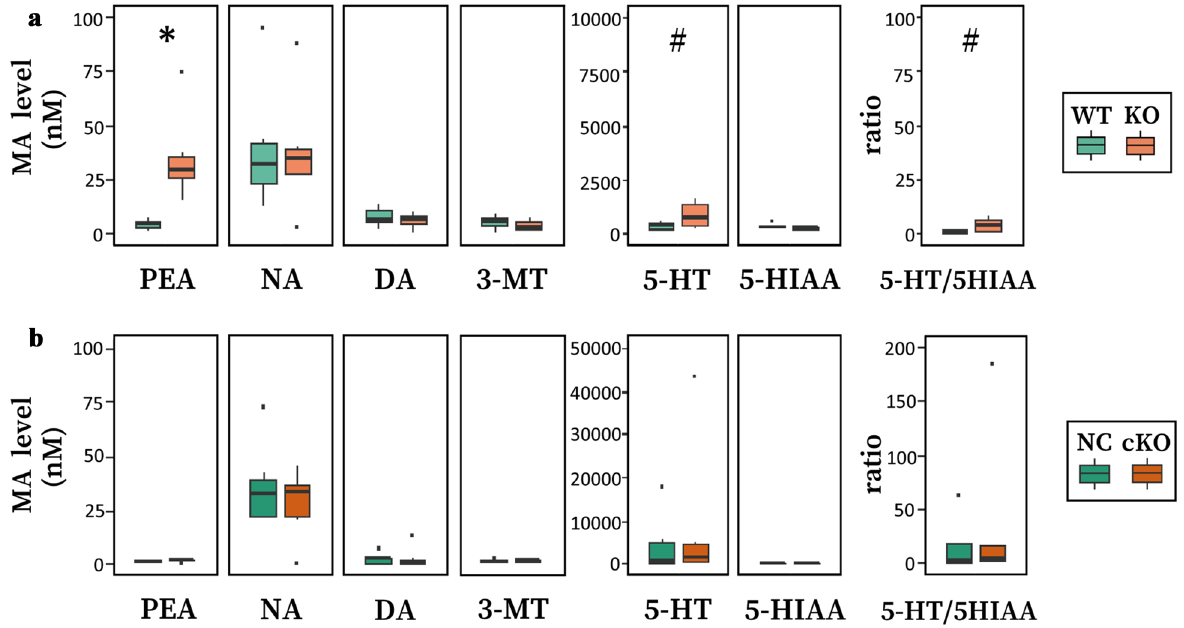
Figure 5. Plasma PEA levels are elevated in global KO mice but not in brain-specific cKO mice. ( a ) Plasma concentrations in wild-type (WT, Maob (+/Y)) and Maob KO (KO, Maob (−/Y)) mice ( n = 6 for each group). Two-way ANOVA showed a significant difference depending on the genotype × substance interaction (genotype: df = 1, F = 3.006, P = 0.0874; substance: df = 6, F = 13.650, P = 3.4 × 10 −10 ; and genotype × substance interaction: df = 6, F = 2.686, P = 0.0210). * P < 0.05, Student’s t- test with Bonferroni correction. ( b ) Plasma concentrations in control Nestin -Cre (NC, Maob (+/Y); Nestin (Tg/+)) and brain-specific Maob KO (cKO, Maob (flox/ Y); Nestin (Tg/+)) mice ( n = 7 for each group). Two-way ANOVA showed no significant difference depending on the genotype × substance interaction (genotype: df = 1, F = 0.305, P = 0.582; substance: df = 6, F = 4.642, P = 0.00040; and genotype × substance interaction: df = 6, F = 0.440, P = 0.850). # P < 0.07, Student’s t